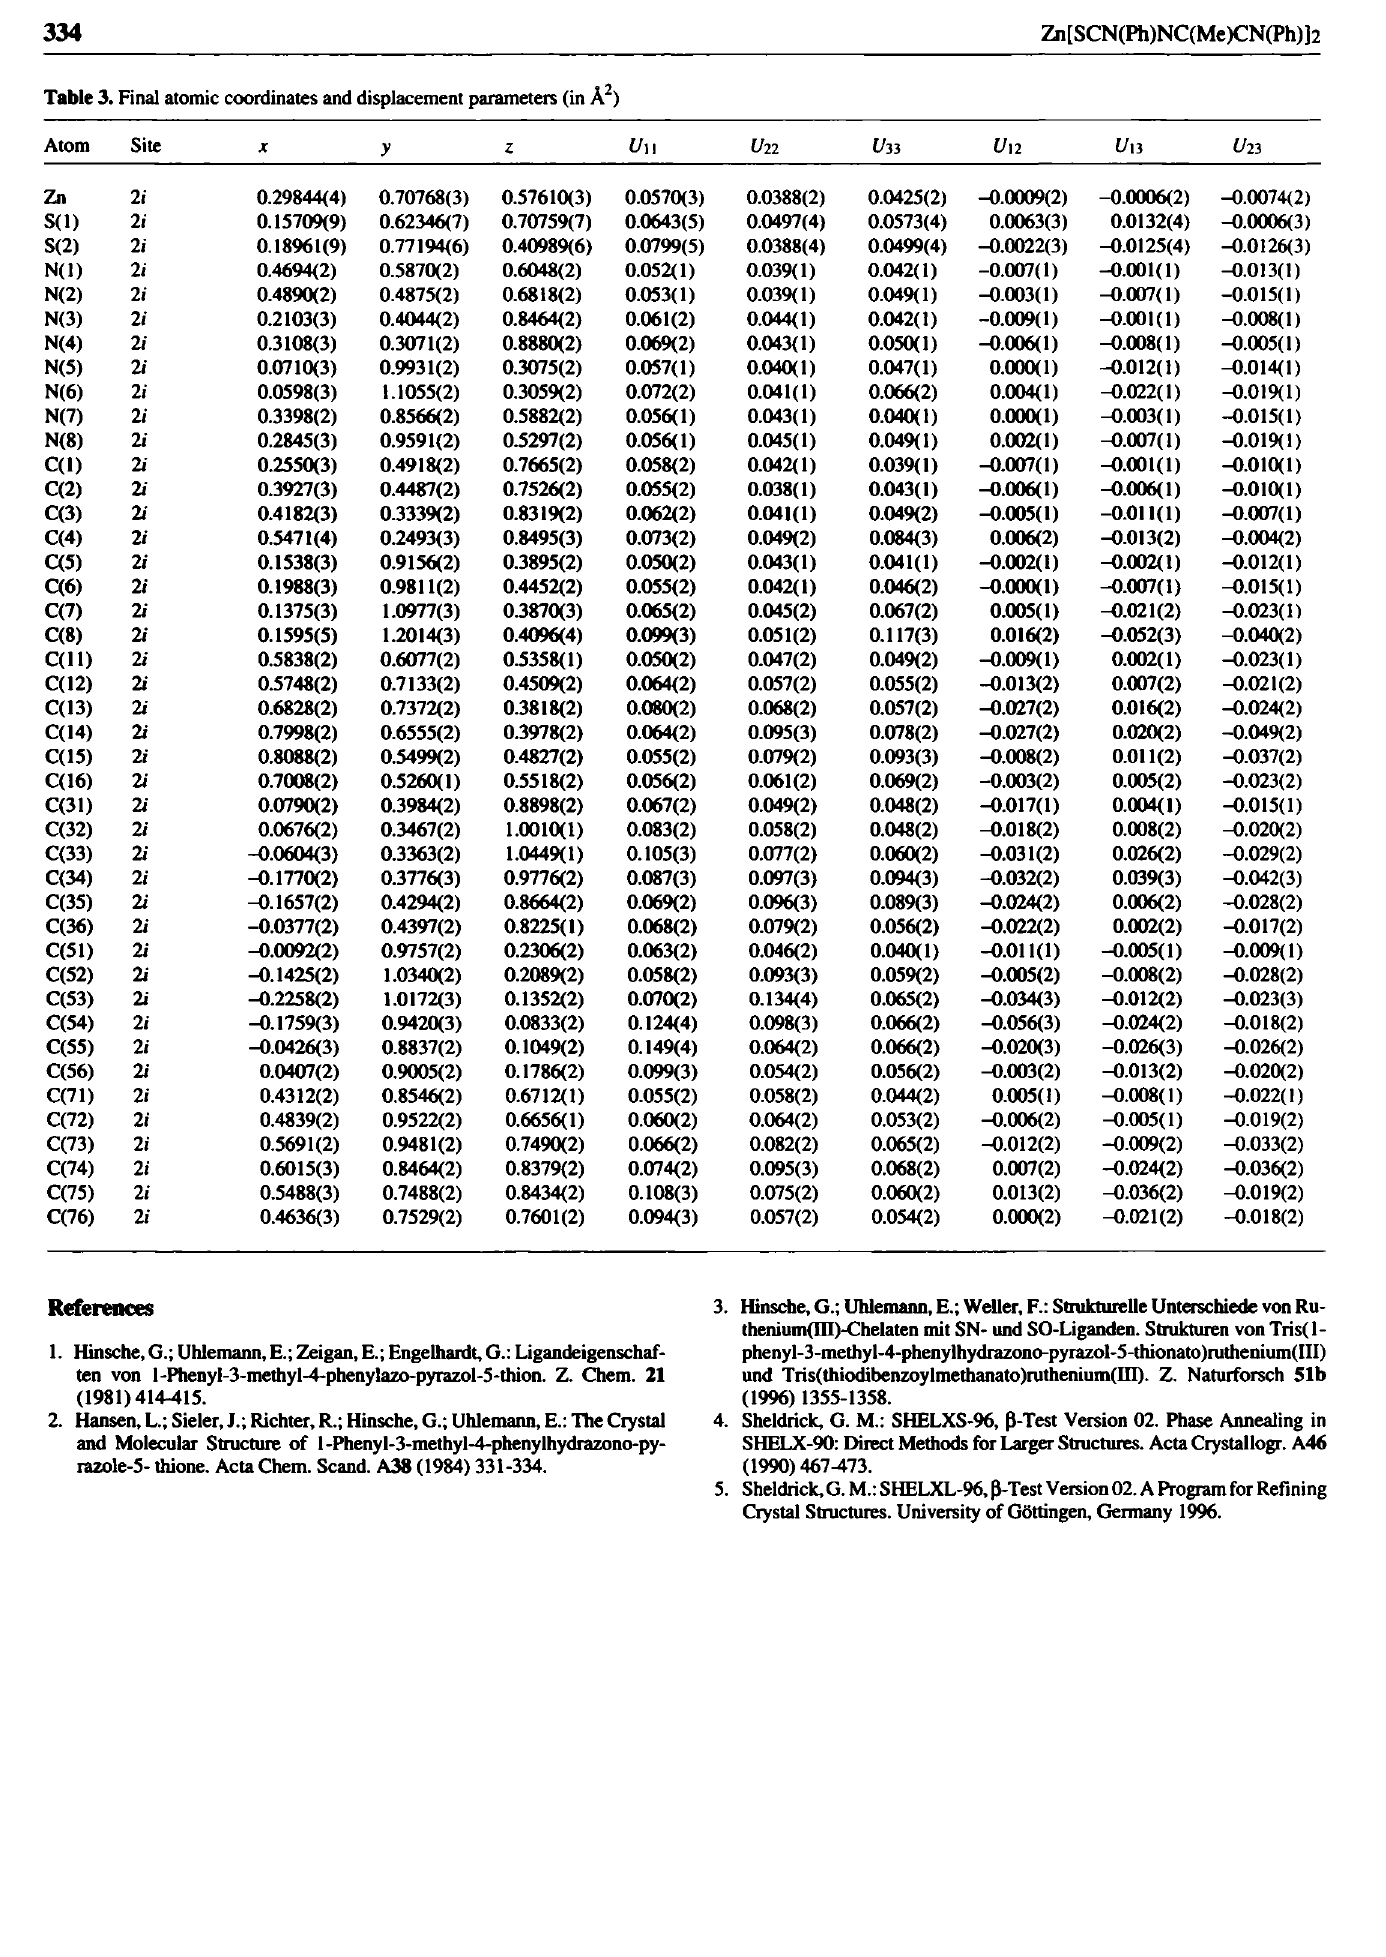
Table 3. Final atomic coordinates and displacement parameters (in Â 2